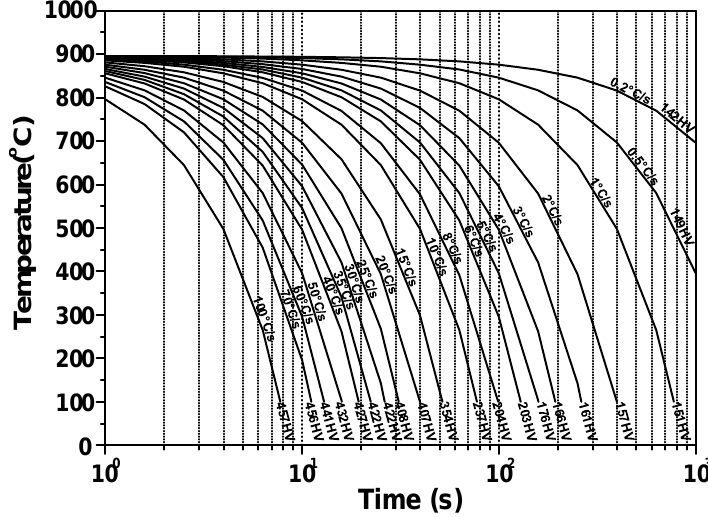
Figure 3. Measured hardness data for various cooling rates obtained using the dilatometer test.